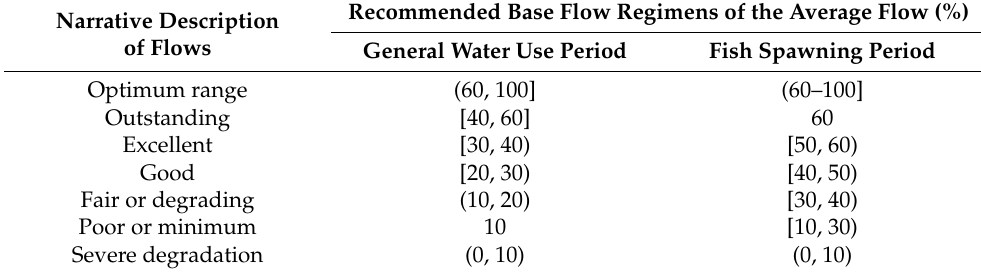
Table 2. The ecological status grading system of the Tennant method